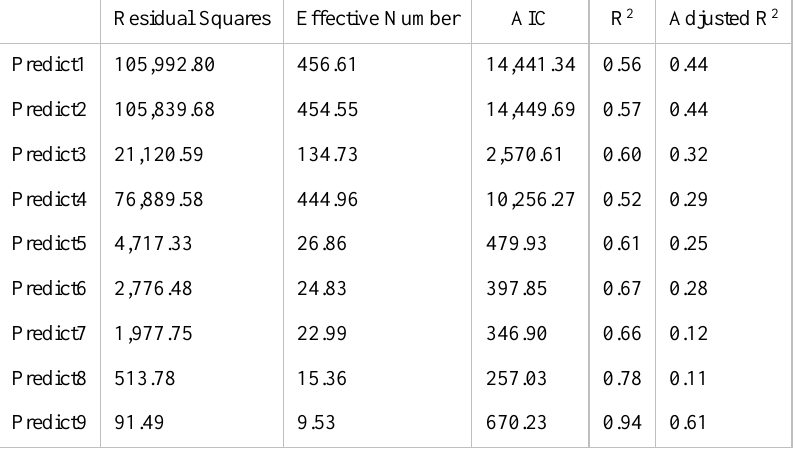
Figure 7 Predicted Height Values from Different GWR Model Structures Residual Squares